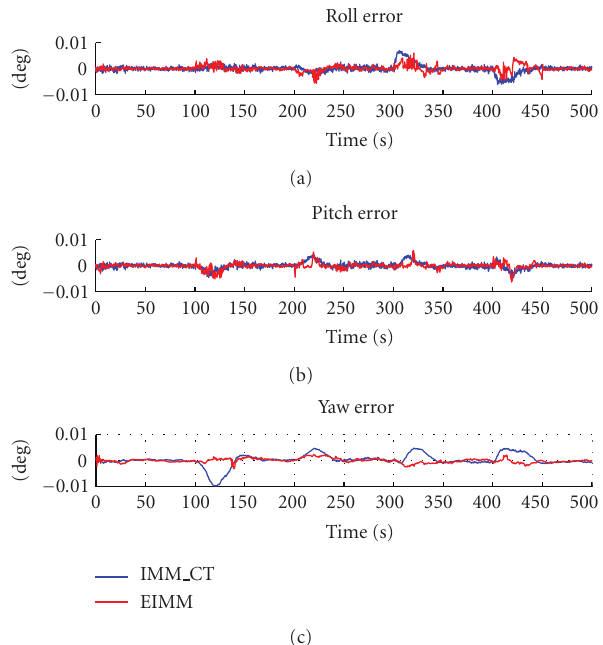
Figure 19: Estimation errors using IMM CT and EIMMAE.